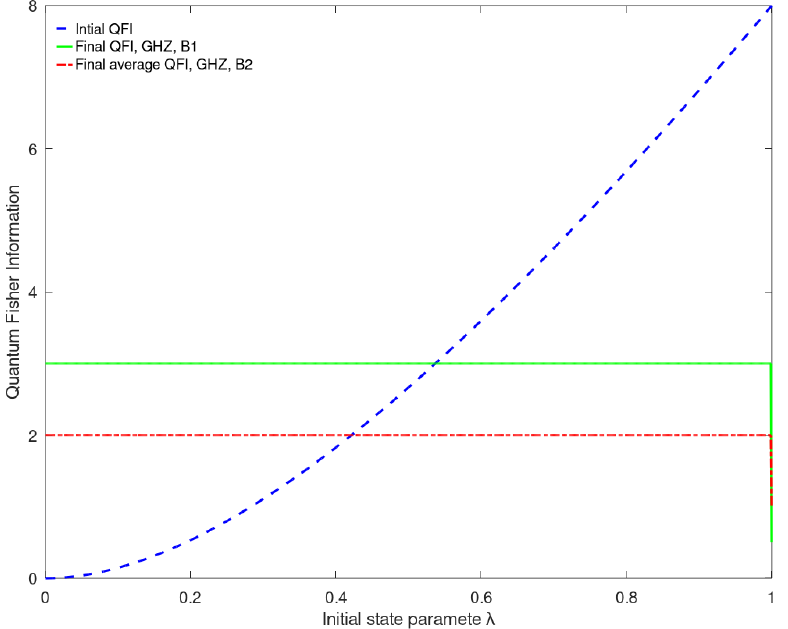
Figure 1. Comparison between the quantum Fisher information attainable by Alice’s initial state ρ A and the average over the quantum Fisher information obtained by Bob’s final states, using 4-qubit Greenberger–Horne–Zeilinger (GHZ) state as a channel. The dashed blue line shows the variation of the quantum Fisher information as obtained by Alice’s initial state with respect to the state parameter λ . The solid green line depicts the average quantum Fisher information obtained by Bob’s final states as a function of the λ of the initial state, when Alice’s register is measured in the basis B 1 , and the red dashed-dotted line represents the final quantum Fisher information (QFI) obtained by Bob’s state after Alice’s qubits are measured in the basis B 2